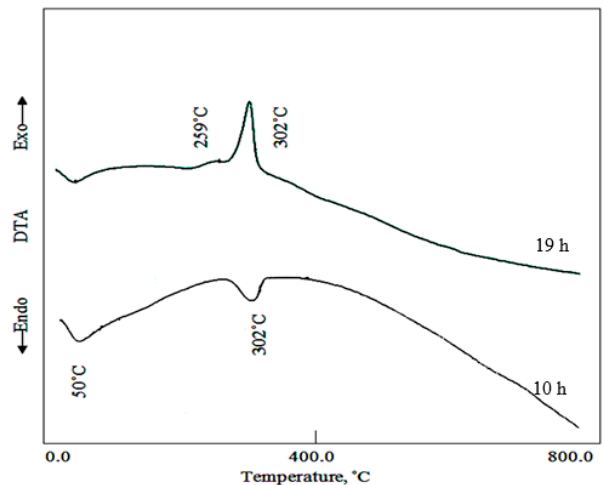
Figure 5. Thermal gravimetric (TG)and Differential thermal gravimetric (DTG) curves of Ni-Ti-4 LDHs at different reaction times.